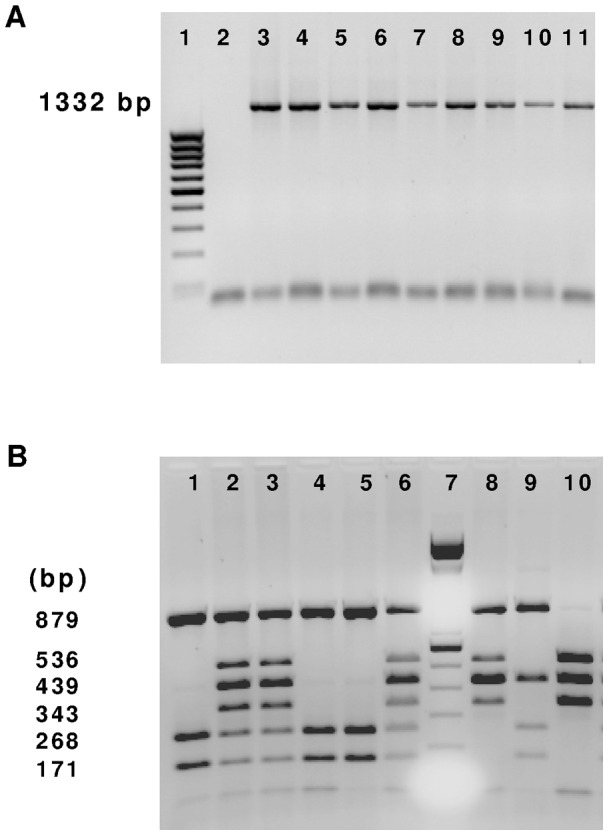
PCR analysis of genomic DNA encoding the glycoprotein Ia gene surrounding the 807, 837 and 873 polymorphisms.
(A) Amplified products (1332 bp) were resolved by 1% agarose gel electrophoresis and stained with ethidium bromide. Lane 1: molecular weight marker; lane 2: blank; lanes 3 to 11: different genotyped individuals. (B) Analysis of ITGA2807C/T, 837C/T, 873 G/A polymorphisms by PCR-RFLP using Bgl II and Asn I endonucleases on 1.5% agarose gel. Lane 7: molecular weight marker; other lanes: different genotypes according to reference 29 (lanes 1, 4, 5: 2/2, lanes 2, 3, 6: 1/2, lane 7: 1/3, lane 8: 2/3, lane 9: 1/1).